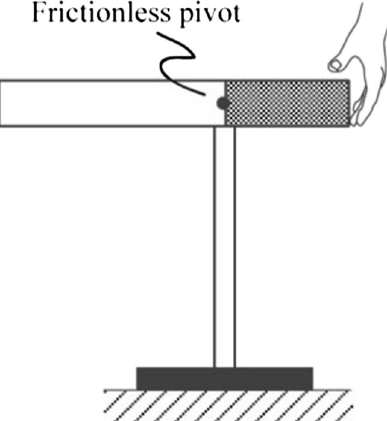
FIG. 4. Figure used in the shaded bar version of the mass comparison task. Students were told that the bar is made of two pieces of different material and that it is balanced on a frictionless pivot and will remain at rest when released. They were asked if the mass of the unshaded (left) piece is greater than, less than, or equal to the mass of the shaded (right) piece.